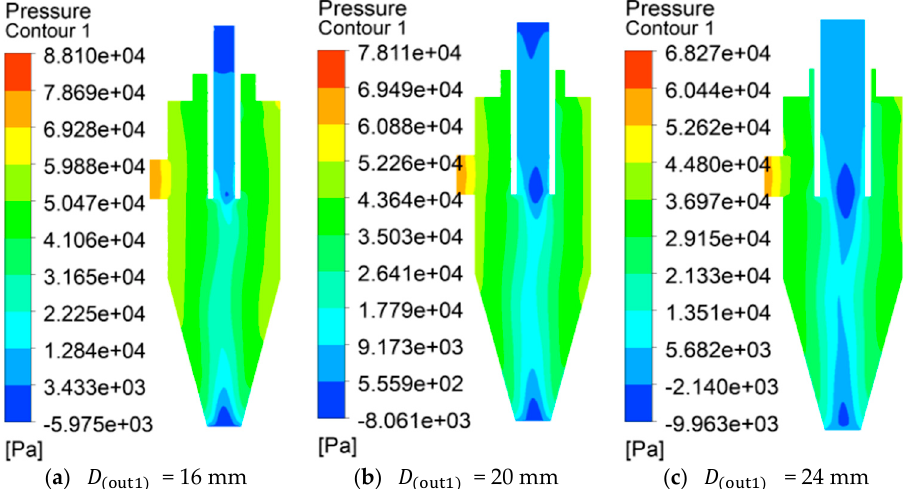
Figure 3. Pressure distribution nephogram of longitudinal section.